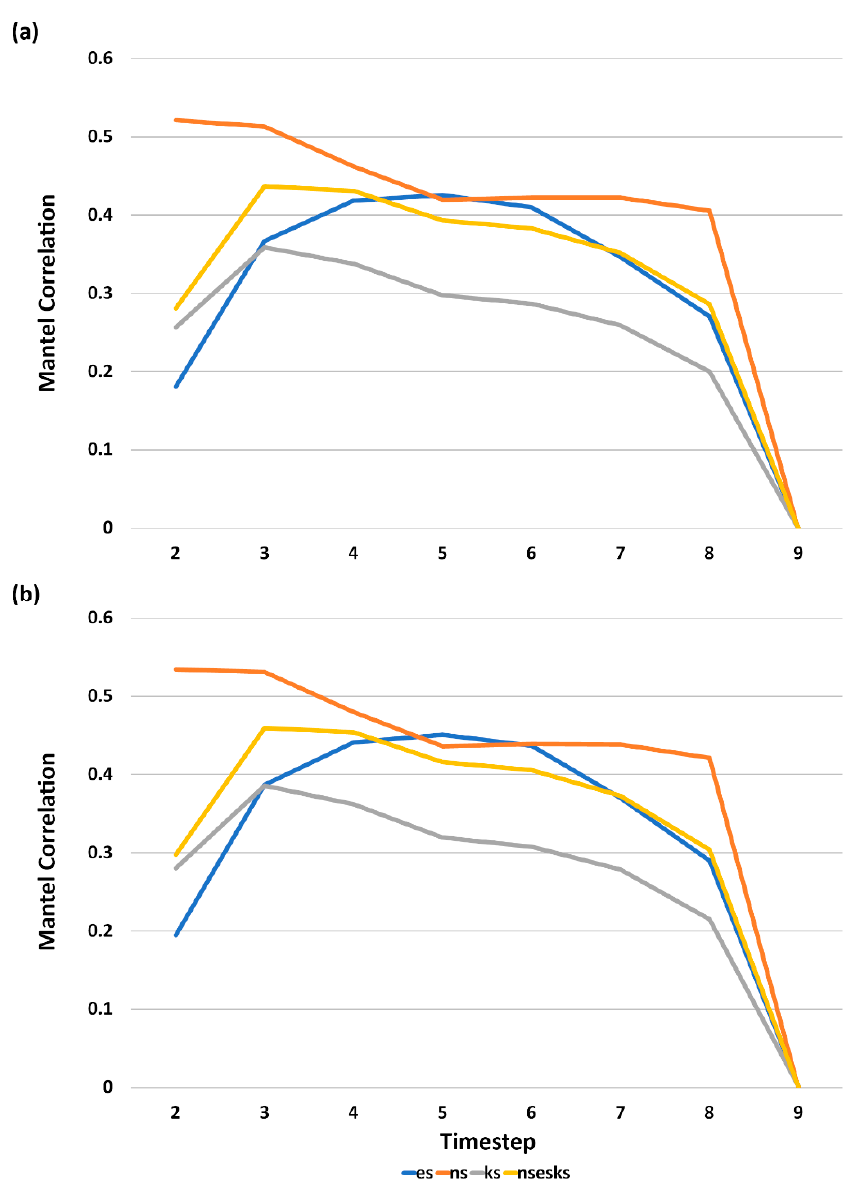
Figure 8. Plot of Mantel correlation of the best model for ( a ) divergence and ( b ) displacement over timesteps for each of the response variables: es—kernel extent, ns—population size, ks—kernel sum, and nsesks—multivariate combination of kernel extent, population size, and kernel sum. In both cases, population size had the strongest correlation with the best scenario model matrix over nearly all timesteps, only equaled by kernel extent in timestep 5.